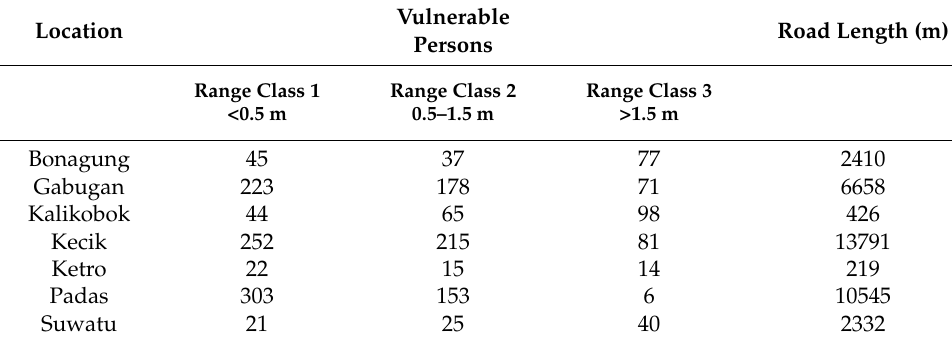
Table 8. Total number of vulnerable persons and length of roads inundated.